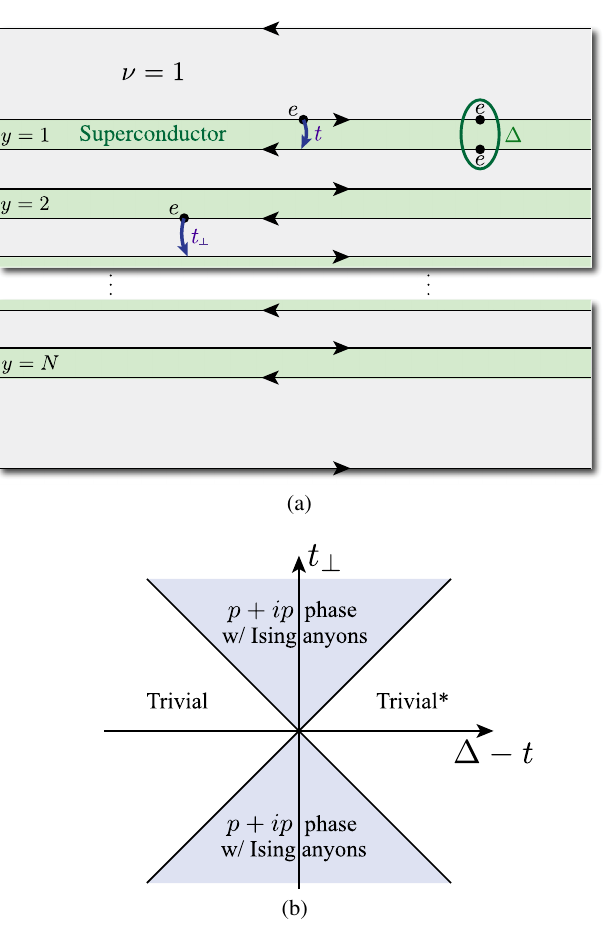
FIG. 2. (a) Setup used to nucleate a p þ ip superconducting state with Ising anyons inside of a ν ¼ 1 quantum Hall fluid. The arrows indicate integer quantum Hall edge states. Uniform superconductors fill each of the N trenches shown. The edge states opposite a given trench can hybridize either through electron backscattering t or Cooper pairing Δ mediated by the intervening superconductor; both processes favor gapping the edge modes, but in competing ways. Adjacent trenches are assumed to couple weakly via electron tunneling t ⊥ . With t ⊥ ¼ 0 and t ¼ Δ , each trench resides at a critical point at which the adjacent quantum Hall edge states evolve into counterpropagat- ing Majorana modes. Turning on t ⊥ then mixes these modes in such a way that “ unpaired ” chiral Majorana edge states survive at the boundary, thus triggering a p þ ip phase. (b) Phase diagram for the weakly coupled trenches near criticality. States that smoothly connect to the limit of decoupled chains are labeled “ trivial ” ; see the text for a more detailed description of their